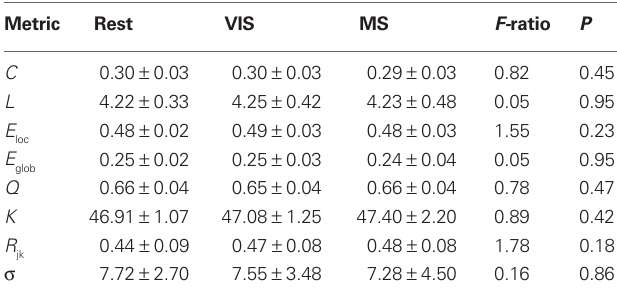
Table 2 | Mean whole-brain network metrics for S =